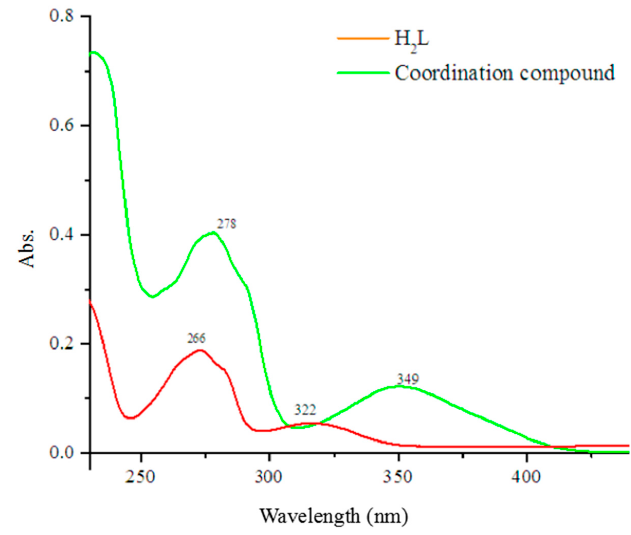
Figure 2. UV-Vis spectra of H 2 L and its Zn(II)-La(III) coordination compound.